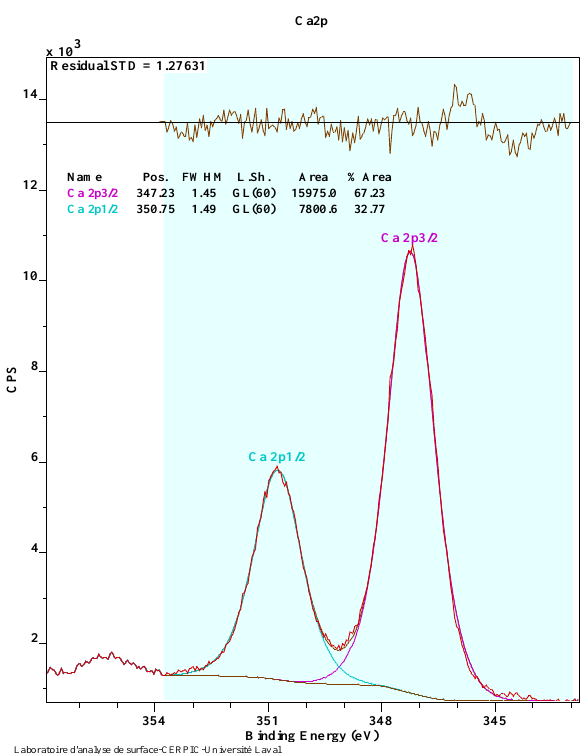
Figure 6. Ca 2 p high resolution spectra on embedded UVAs into CaCO 3 sample.